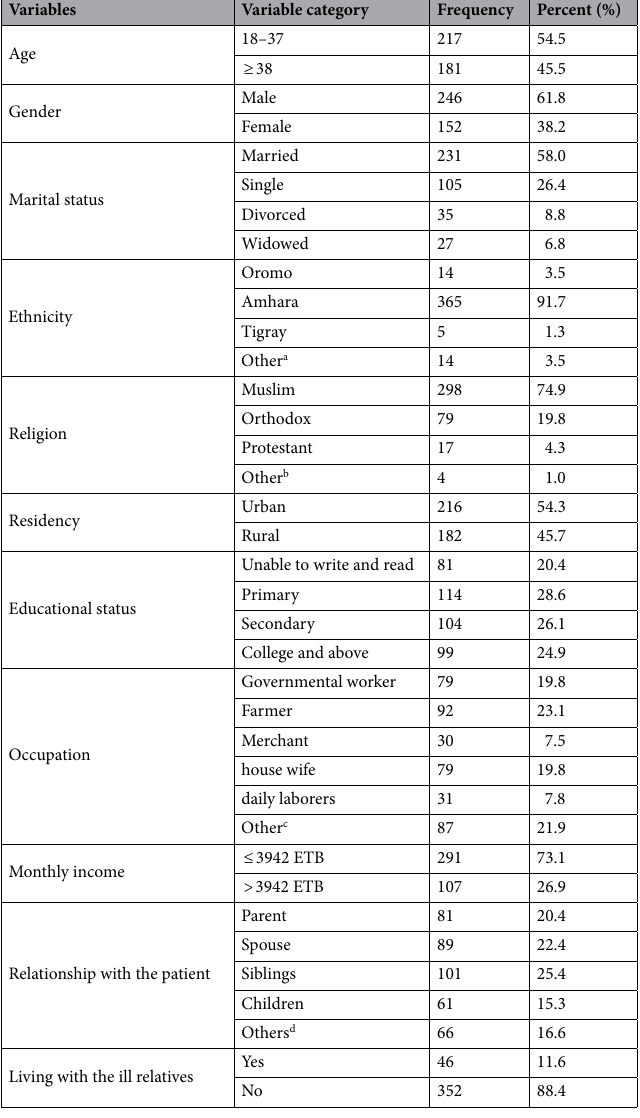
Table 1. Distribution of participants by socio-demographic characteristics of participants (n = 398) at DRH, Ethiopia, 2020. Other a includes (Guragie). Other b includes (catholic religion). Other c includes (students, jobless or unemployed). Others d includes (aunt, uncle, grandfather and